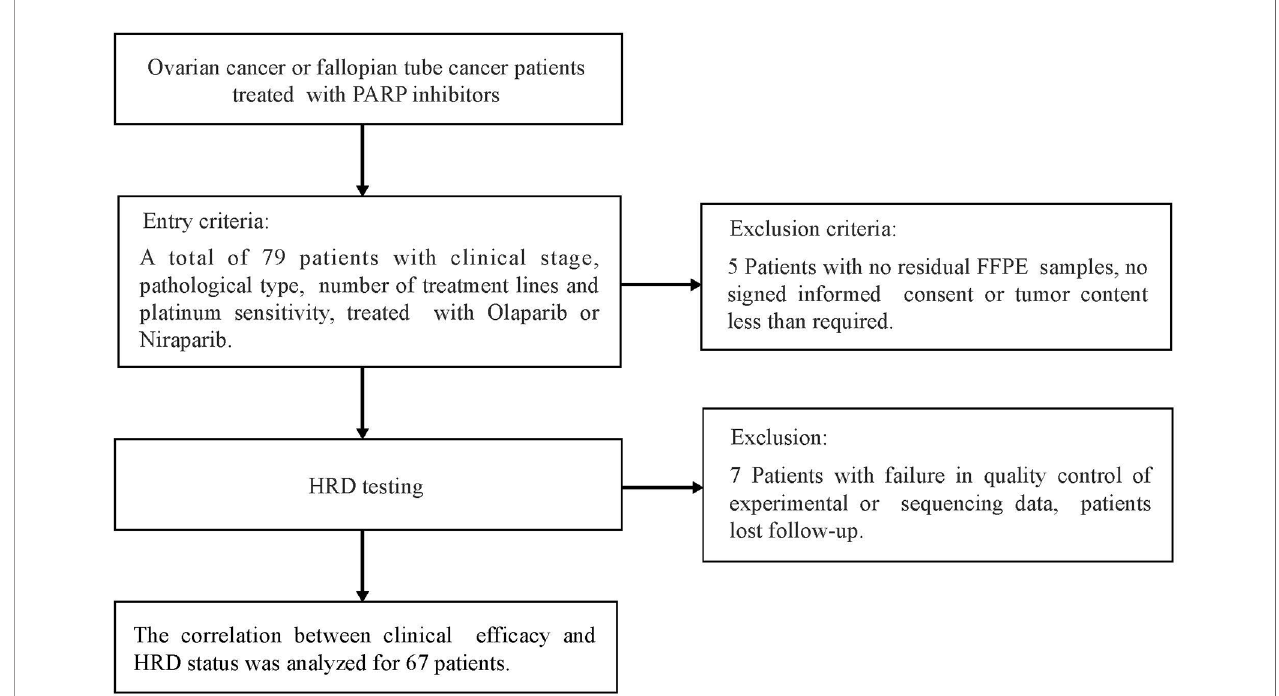
FIGURE 1 | Flow Diagram for the Real world PARPi treatment data cohort, patient inclusion and exclusion criteria of patients used for